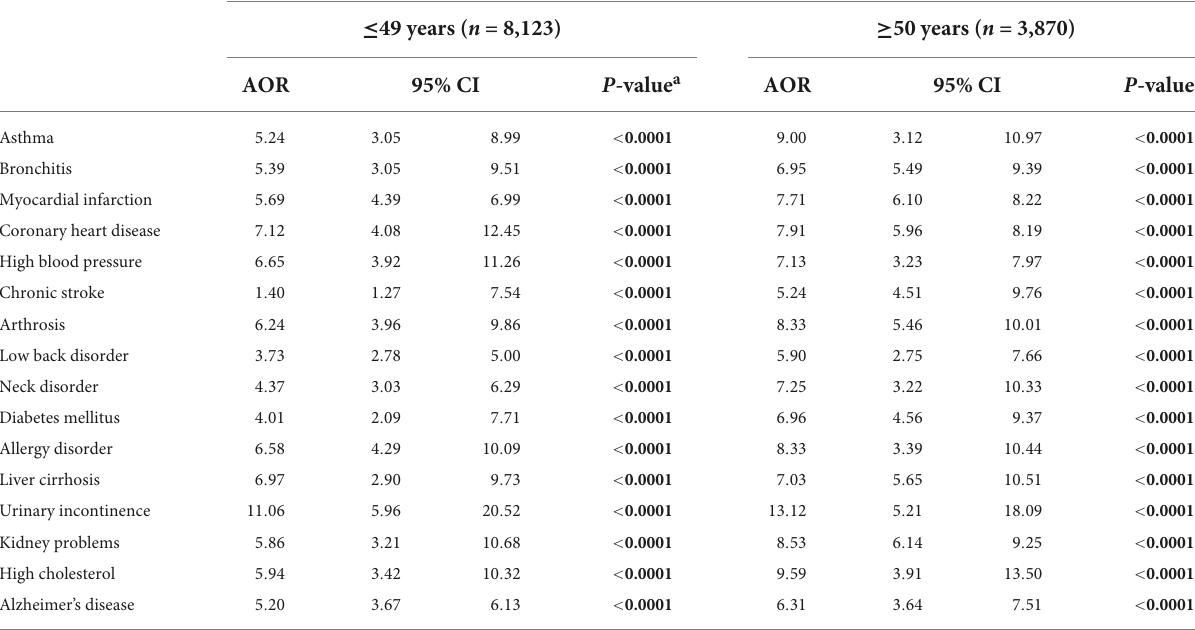
TABLE 4 Multivariate regression models for history of chronic diseases by age.*